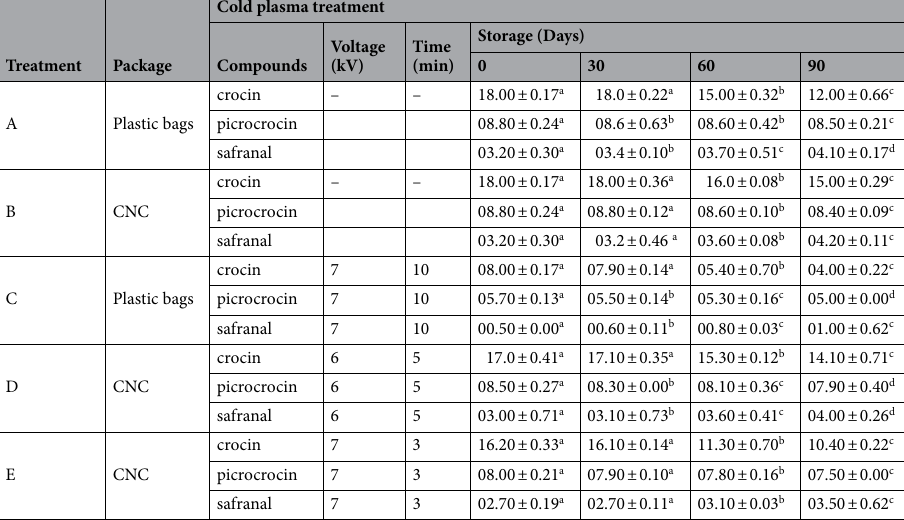
absorption of nano clay into the CMC/PVA film followed by its subsequent release, while the structural properties of CNCs are modified. On the other hand, CNCs film might carry plasma-derived antibacterial agents. In this way, the synergy of CP treatment and CNCs leads to the complete inactivation of E. coli bacteria. The mechanism of plasma-assisted inactivation of E. coli bacteria is related to the cell envelope damage-induced leakage owing to plasma-generated ROS/RNS, especially H 2 O 2 , NO X , and ozone reactive species 76 . The obtained results about the replication and survival of E. coli in 90 and 180 days 77 of storage may be due to a combination of different factors. First, E. coli ’s survival and growth can potentially be affected by the fluctuat- ing temperature circumstances utilized in this investigation 78 . Second, the ability to survive and even flourish in E. coli in low carbon content environments is due to the production of RpoS (subunit of RNA polymerase) 79 . Third, the absence of predatory, antagonistic, or competing species has been accompanied by the survival of E. coli bacteria 79 . Fourth, exhibiting higher levels of transcription for stress defense genes compared to commensal bacteria in E. coli bacteria under carbon-limited growth circumstances 80 . Fifth, as a result of plasma treatment, the C–C and C–H bonds in the polymer chain are broken, giving birth to carbon radicals 62 . Sixth, the complex interplay amongst CMC, PVA, and nanoclays has led to carbon resources. All of these points allow the survival of the pathogen for long periods of time. Considering these explanations, we need to rethink what we know about how E. coli survive in an open environment, both in terms of how the environment affects it and how the organism’s DNA affects it. It is noteworthy that although cell concentration at time zero was not the same for all the treatments, the number of E. coli cells (Log CFU/gr) was analyzed compared to different storage (days) of each treatment in a row. Time 0 represents cell concentration after the saffron powder has been sprayed with E. coli. At that time, the samples underwent extensive analysis for the isolation and enumeration of the E. coli bacteria from other bacteria, considering the cultural characteristics of E. coli by the CFU method. We did this so all treatment groups could follow the same regimen, specifically the same storage duration times. Moreover, the initial cell concentra- tions of each treatment procedure did not affect the other one because the data analysis was conducted so that each group was compared to itself and only the changes between groups were discussed. Insufficient performance of cold plasma and packaging alone against saffron contamina‑ tion. Furthermore, by evaluating CP and CNCs methods’ effects separately in E. coli inactivation, we showed that these modalities are not able to provide appropriate decontamination for saffron preservation. At doses that did not damage the quality of saffron, plasma alone was not able to eliminate microbial contamination. Only with irradiation for more than 10 min the total contamination disappears. However, in the latter case, the con- centration of crocin, safranal, and picrocrocin is significantly reduced. Besides, the CNC packaging of saffron led to 0.9, 2, and 2.6 log CFU/gr reduction of E. coli after the 30, 60, and 90 day storage periods, respectively